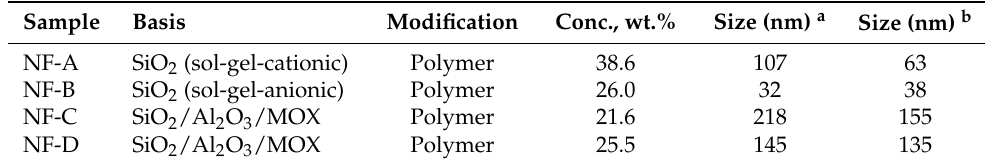
Figure 2. Concentrated aqueous solutions of silica nanoparticles. Table 1. Properties of the aqueous solutions of silica nanoparticles.